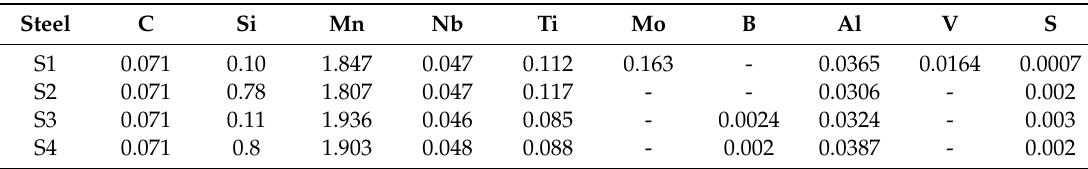
Table 1. Chemical composition of experimental steels (in wt.%).